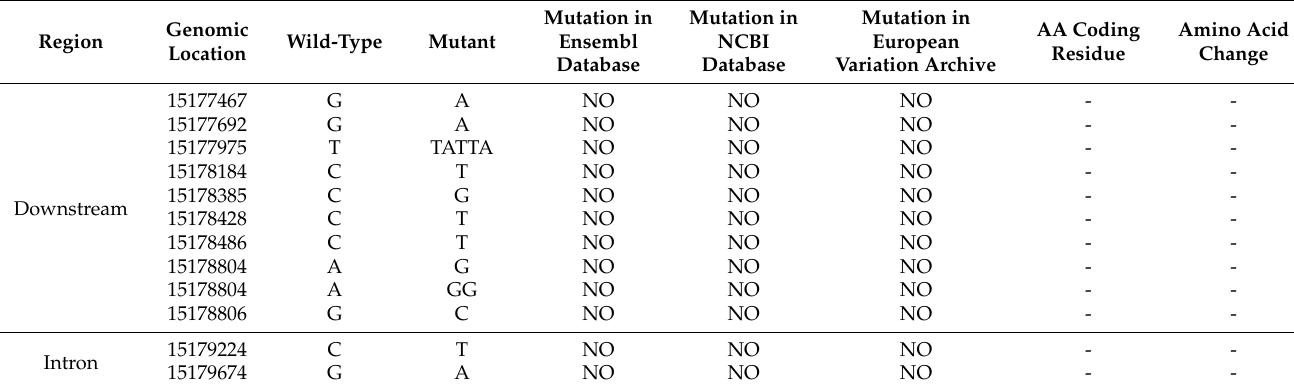
Table 2. The information of 12 mutation loci in the HOXC8 gene of Dezhou donkeys.